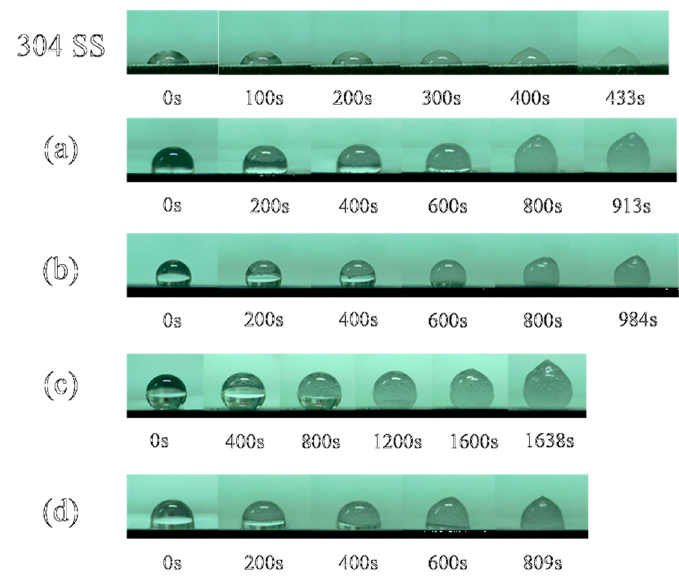
Figure 8. In situ icing on the surface of the sample.